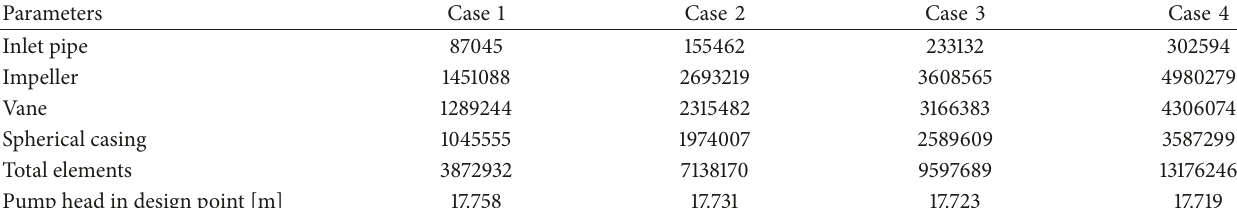
Table 2: Grid independence check.